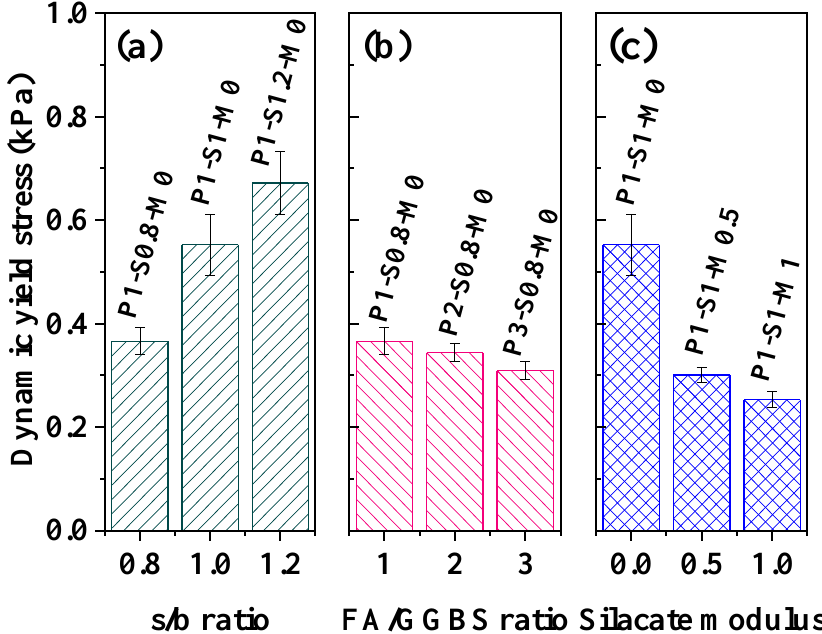
Figure 4. The dynamic yield stress of AAFS mortar after mixing. ( a ) effect of s/b ratio, ( b ) effect of FA/GGBS mass ratio, ( c ) effect of silicate modulus.